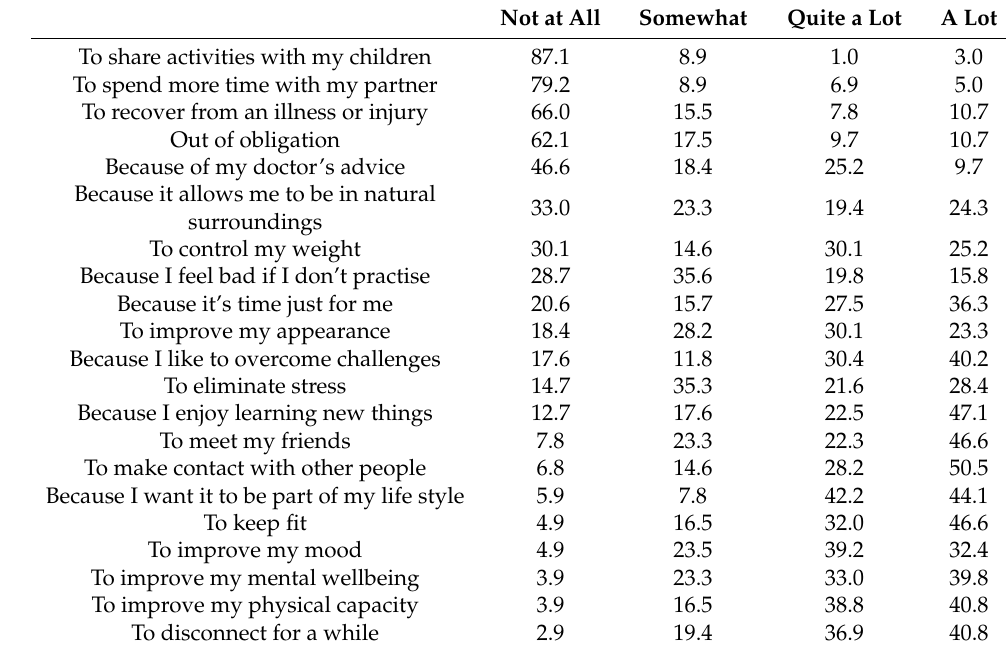
Table 2. Results (%) referring to the motives for practising physical activity and sport perceived by all the participants in the